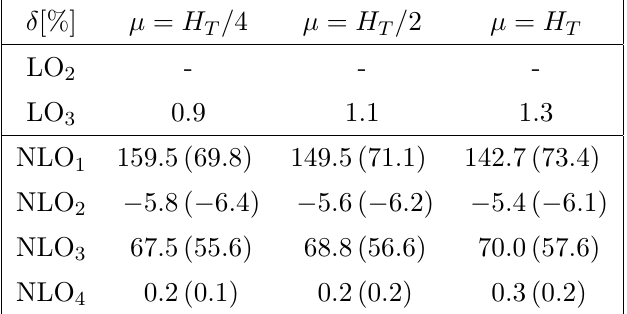
not depend on an external renormalisation scale. Moreover, the O ( (cid:11) ) PDF counterterms induce a much smaller e(cid:11)ect than those of QCD, since they are O ( (cid:11)=(cid:11)